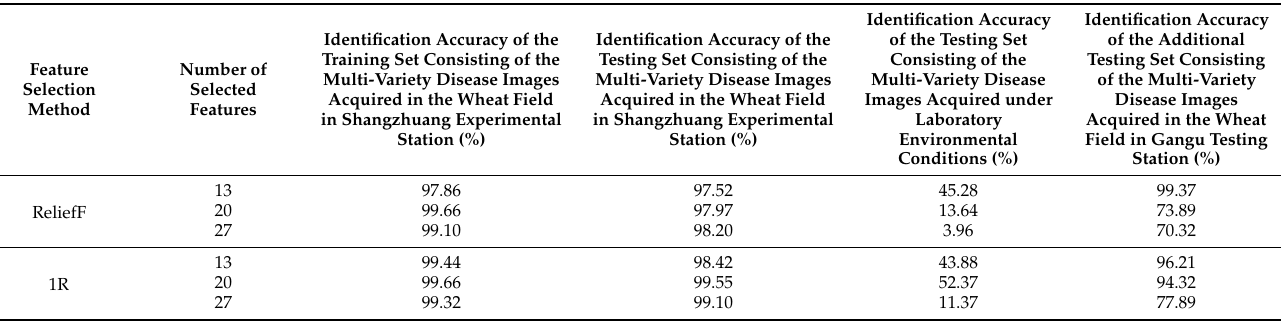
Table 7. Disease identification results of the BPNN models built with features selected based on the multi-variety disease image dataset consisting of images acquired in the wheat field in Shangzhuang Experimental Station using feature selection methods including ReliefF and 1R,